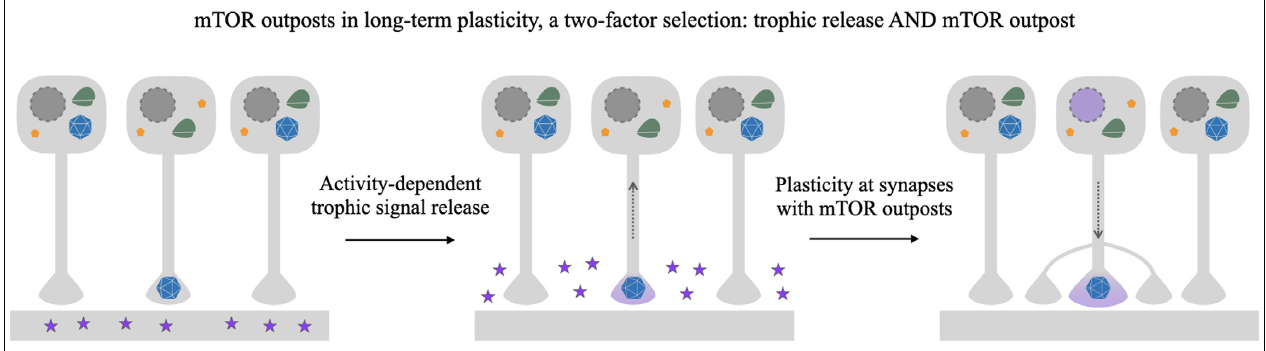
FIGURE 4 | mTOR outpost model in gating long-term plasticity. Schema depicting selective strengthening of connections via target-derived trophic signaling and selective localization of putative presynaptic mTOR outposts. In this example, three neurons synapse onto the same segment of dendrite on a postsynaptic neuron. Of the presynaptic cells, only one has an mTOR outpost (blue polyhedron) at the presynaptic terminal, while the other two have somatodendritically localized mTOR. Potentiating synaptic activity causes the postsynaptic neuron to release trophic factors such as BDNF (purple stars) in the vicinity of the presynaptic terminals. While all terminals may have receptors, only terminals containing a presynaptic mTOR outpost will be able to transduce mTOR-dependent signaling to the nucleus, resulting in selective nuclear response (purple nucleus) to activity-dependent target-derived signaling. mTOR-dependent structural plasticity will selectively occur only on contacting presynaptic cells with an axon-localized mTOR outpost, a selection criterion gating plasticity that can be overlaid and combined with direct activity-dependent plasticity mechanisms.